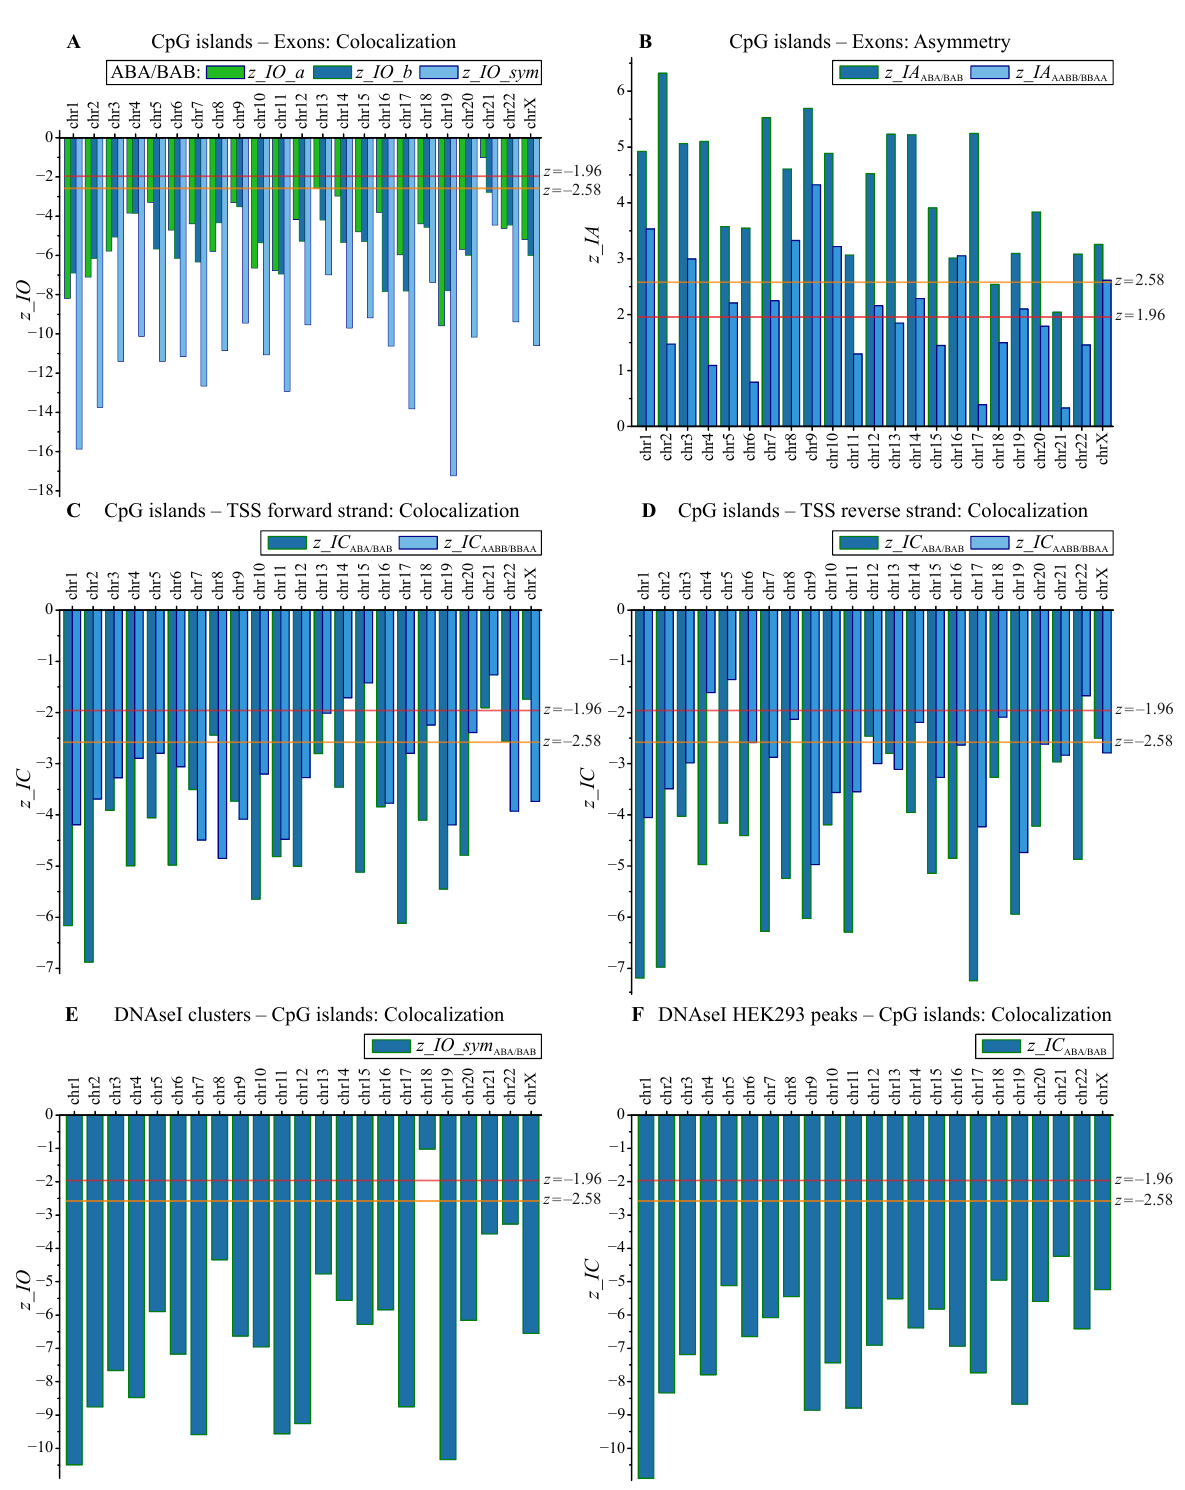
Figure 6. Distribution over human chromosomes of the Gaussian z -variables for the assessment of statistical significance of the mean indices on Figure 5 by permutation tests. The thresholds for probabilities Pr = 0.05 and 0.01 are shown by horizontal lines ( z = ± 1.96 and z = ± 2.58, respectively). The Gaussian z -variables for the assessment of statistical significance of mean indices for: ( A ) CpG islands and exons, by Equations (6) and (7); ( B ) CpG islands and exons, by Equation (8); ( C ) CpG islands and TSS on the forward strand, by Equation (9); ( D ) CpG islands and TSS on the reverse strand, by Equation (9); ( E ) DNAseI clusters and CpG islands, by Equation (7); ( F ) DNAseI HEK293 peaks and CpG islands, by Equation